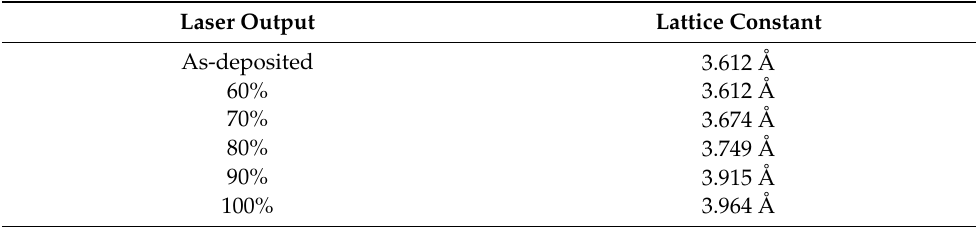
Table 1. Lattice constant before and after the carbon doping through the Rietveld refinement.